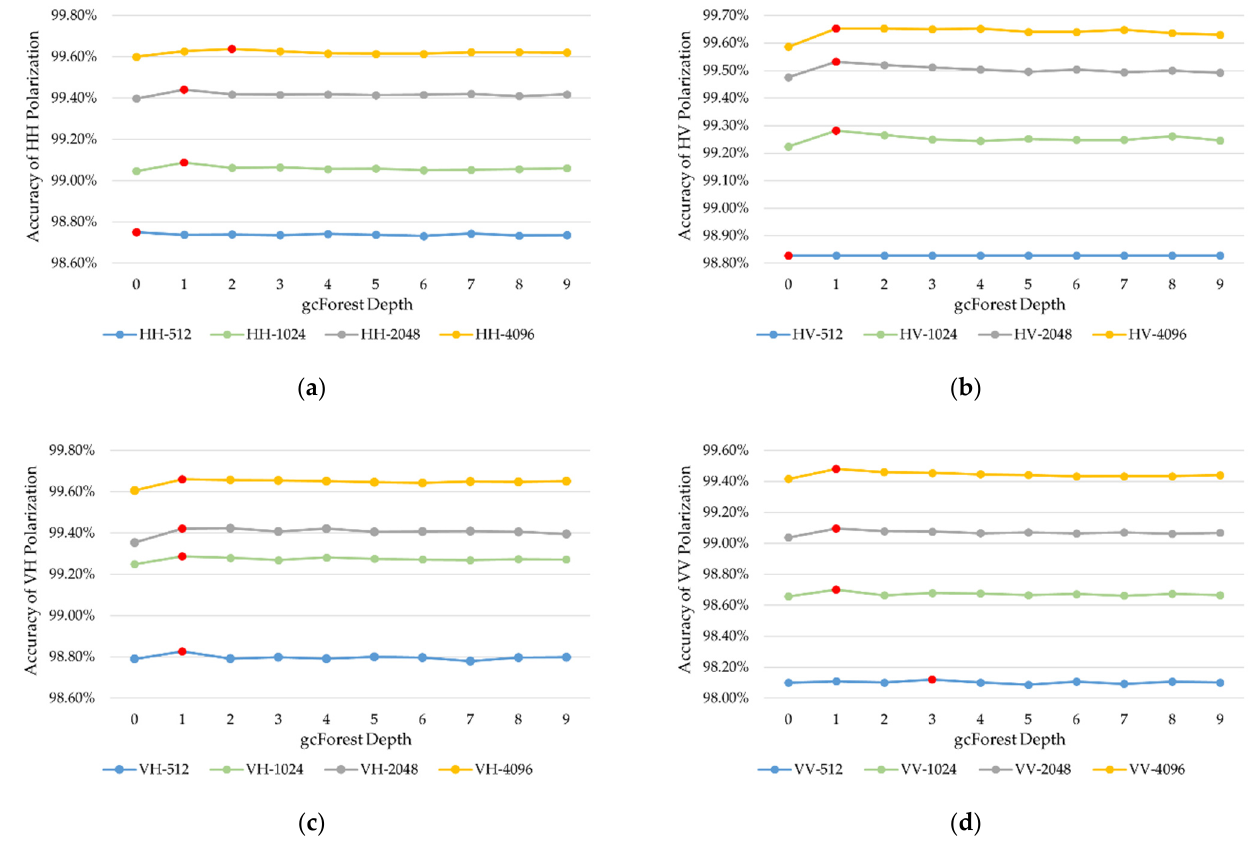
Figure 16. The influence of gcForest on detection probability of different polarization, red points in charts are the points with the highest detection probability. ( a ) HH polarization; ( b ) HV polarization; ( c ) VH polarization; ( d ) VV polarization.